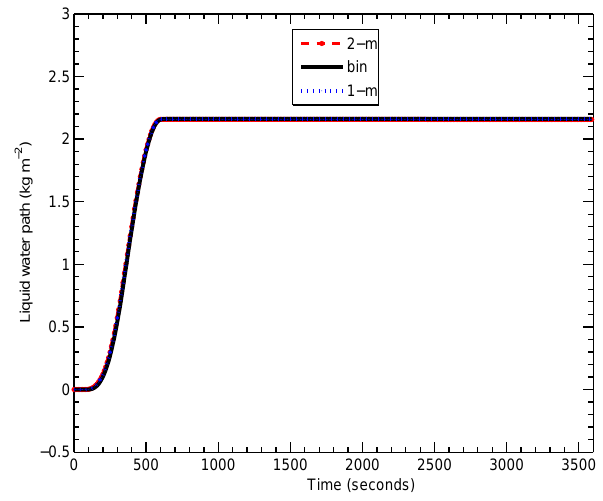
Fig. 3. Timeseries of liquid water path from the 1-m, 2-m A-R and bin schemes in the absence of precipitation and sedimentation, such that all condensed water stays in the cloud. The results shown were obtained with the following settings: w 1 =2ms − 1 , T =RICO and CCN=100/cc.